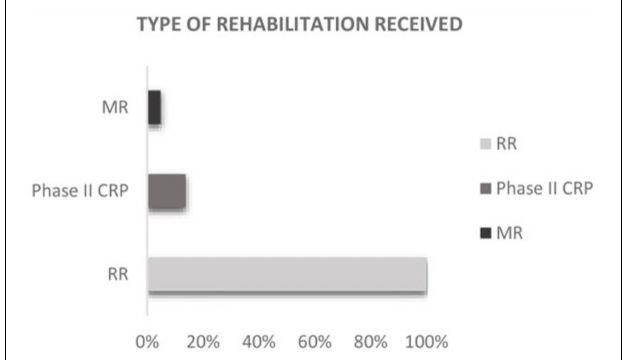
FIGURE 3 | Type of rehabilitation received among the study